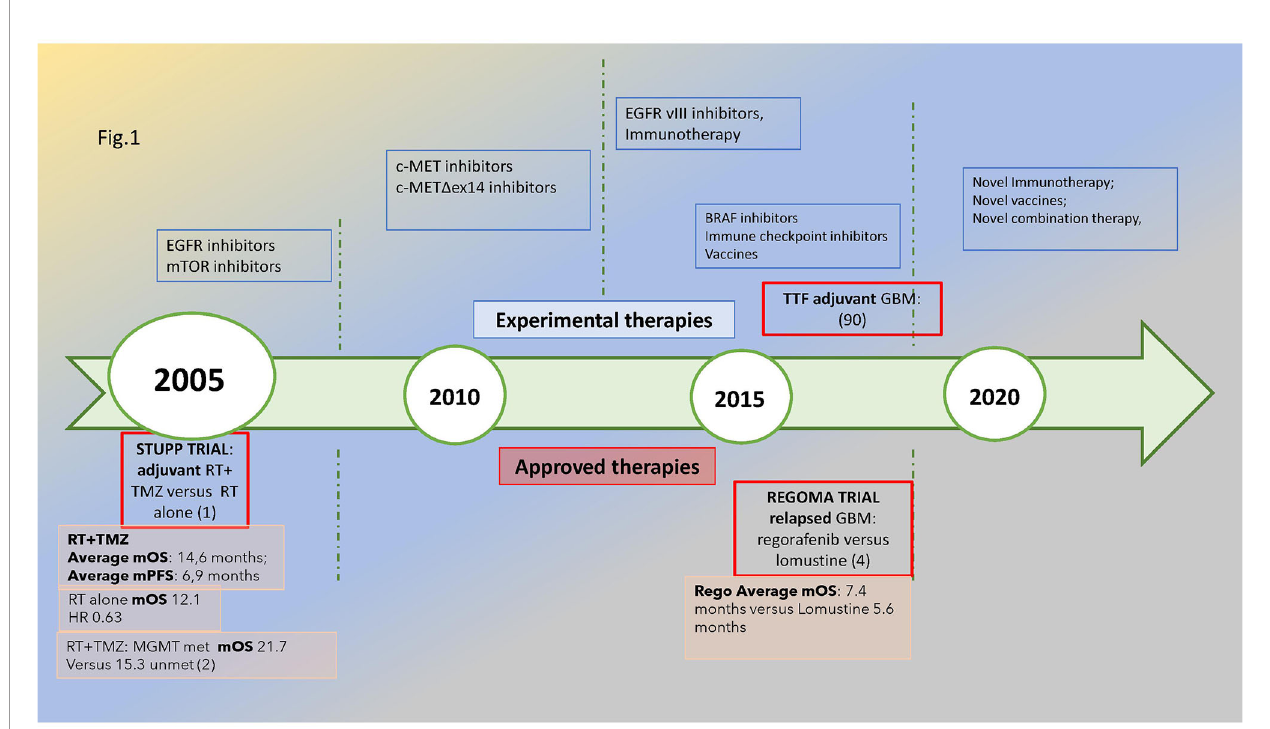
FIGURE 1 | Glioblastoma ’ s treatment timeline: in the upper part of the fi gure, the novel treatments under investigation are reported, while in the lower part are the approved treatments in the adjuvant and relapsed phases with a reported signi fi cant improvement in survival, i . e ., STUPP and REGOMA trial, respectively, dated 2005 and 2019. The median overall survival for the experimental and control arms is also reported. The methylation of MGMT promoter is associated with improved survival compared with unmethylated subtypes. Met, methylated; unmet,